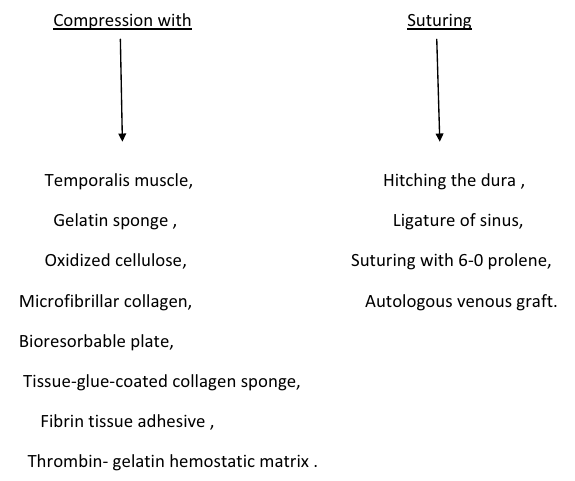
Fig. 1 Methods to control dural venous sinus